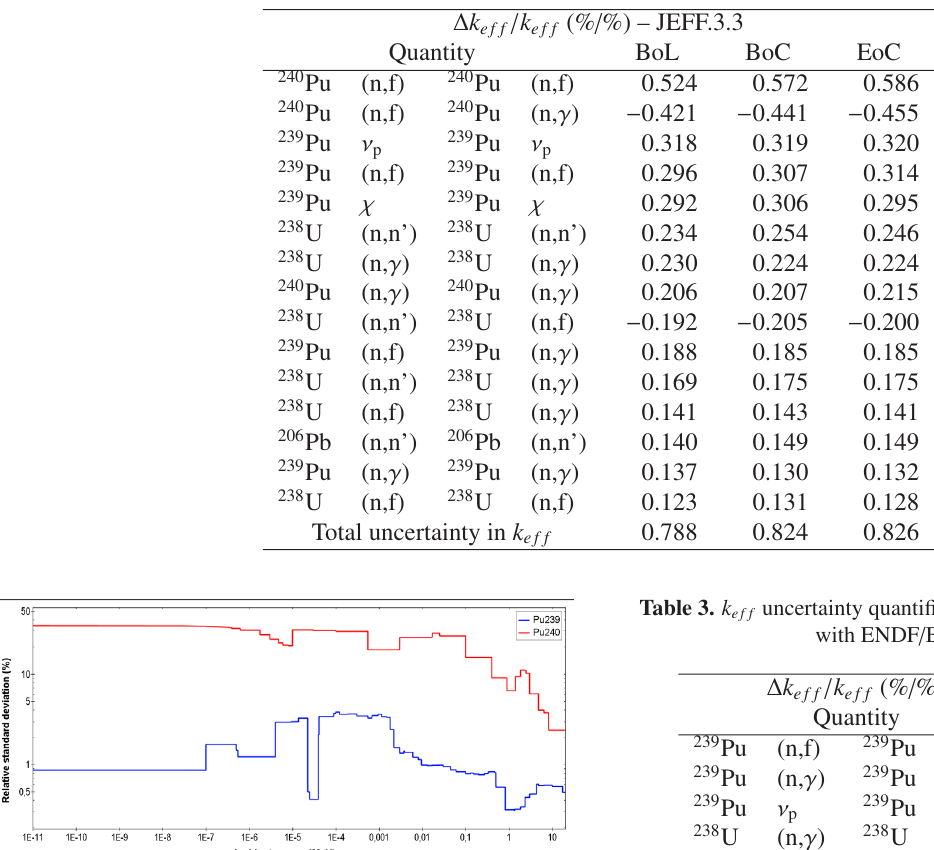
/ k ∆ k / %) – JEFF.3.3 ef f ef f (%